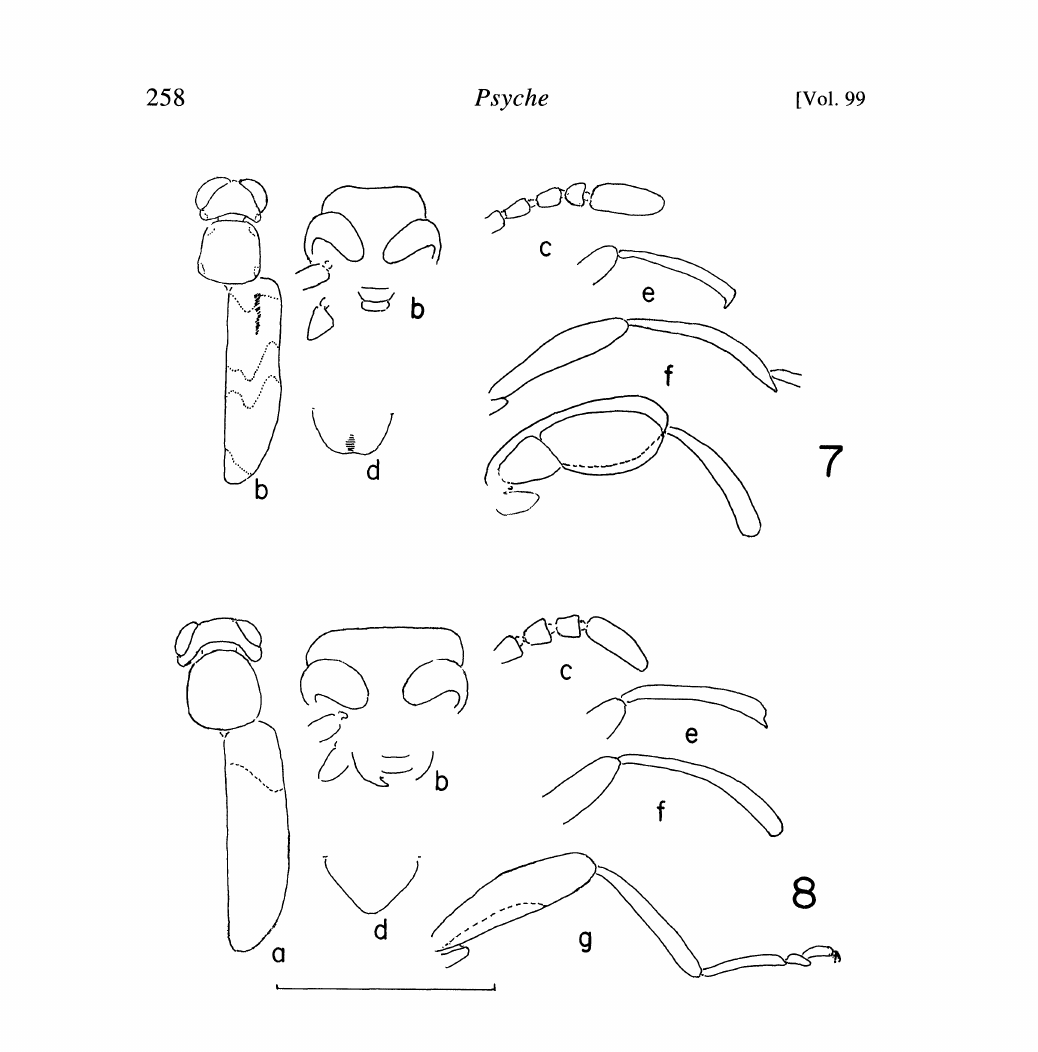
Figs. 7-8. Camera lucida sketches of males of Elonus species. 7, E. nebulosus (LeConte), Latimer Co., Oklahoma. 8, E. simplex, sp. n., holotype. Explanation of letters and scale as on Figs.